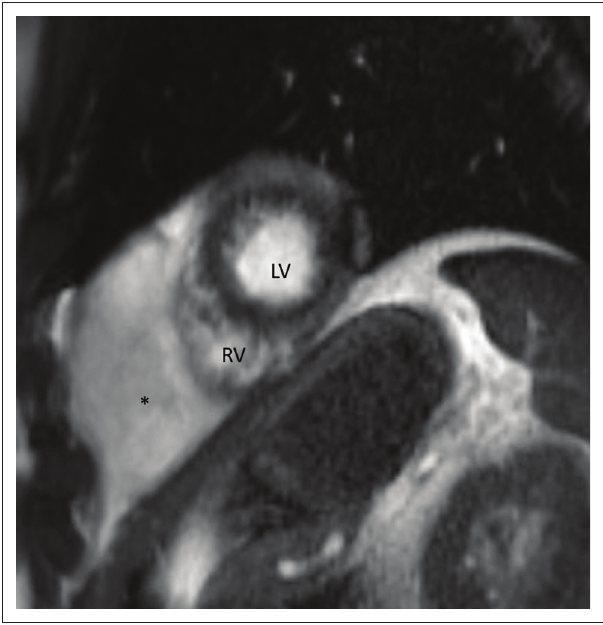
ba LV, left ventricle; RV, right ventricle. FIGURE 10: A 33-year-old man with liposarcoma of the pericardium. The axial black blood image demonstrates a large hyper-intense mass arising from the pericardium adjacent to the right ventricle (black